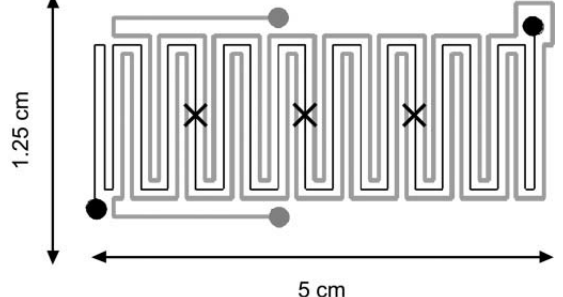
Figure 10. Sketch of the device composed of a working channel (depicted in black) together with parallel channels containing the conductive liquid (depicted in gray). Crosses stand for the position of thermocouples. Reprinted with permission from [41]. Copyright 2004, Royal Society of